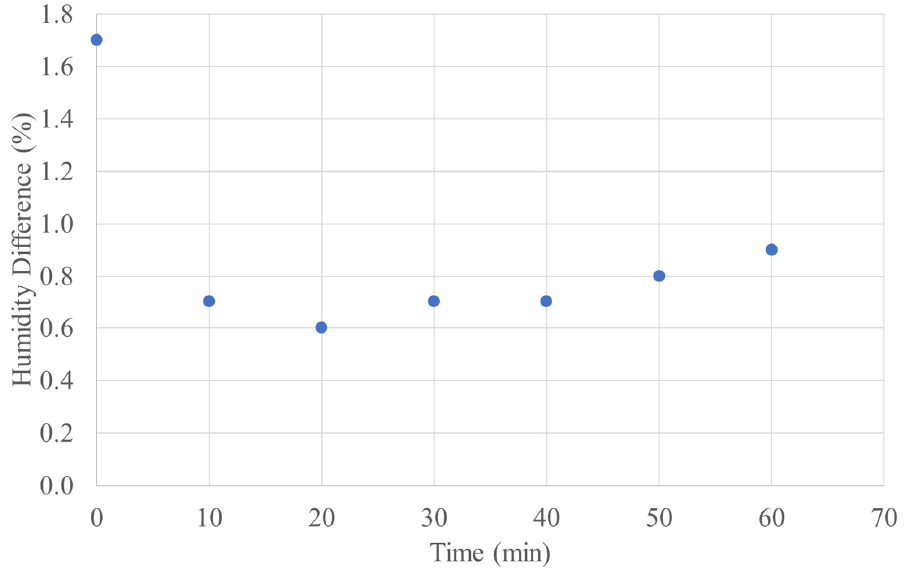
Figure 9. Errors in humidity difference without activation of compressor in the Cascade System for Biomineralization in Cement.